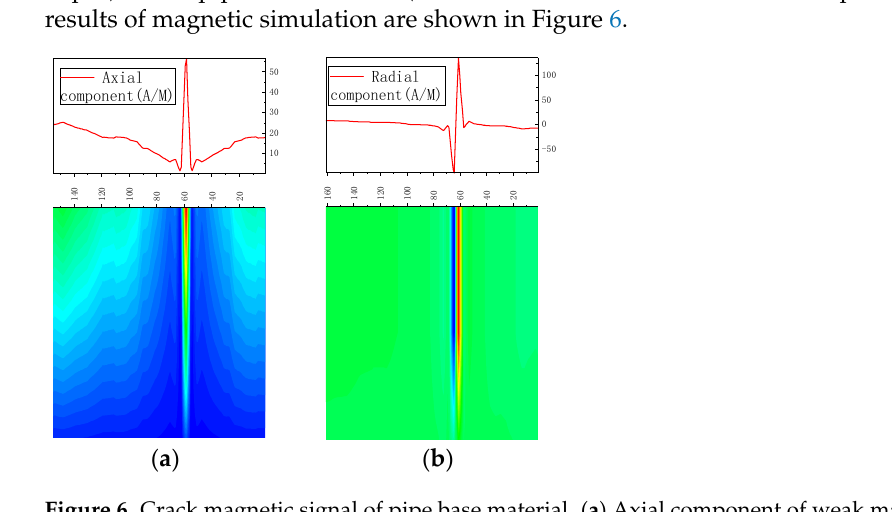
Figure 5. Magnetic signal of weld cracks in the pipe. ( a ) Axial component of weak magnetic signal; ( b ) radial component of weak magnetic signal.